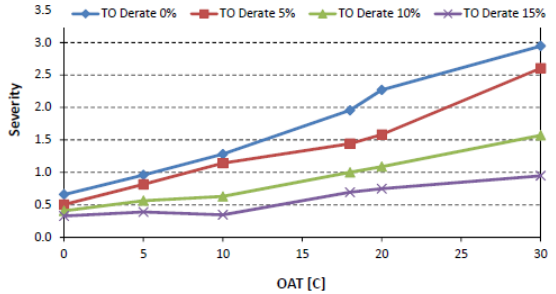
Figure 10: Severity characteristics for the variation in OAT and take- off derate.